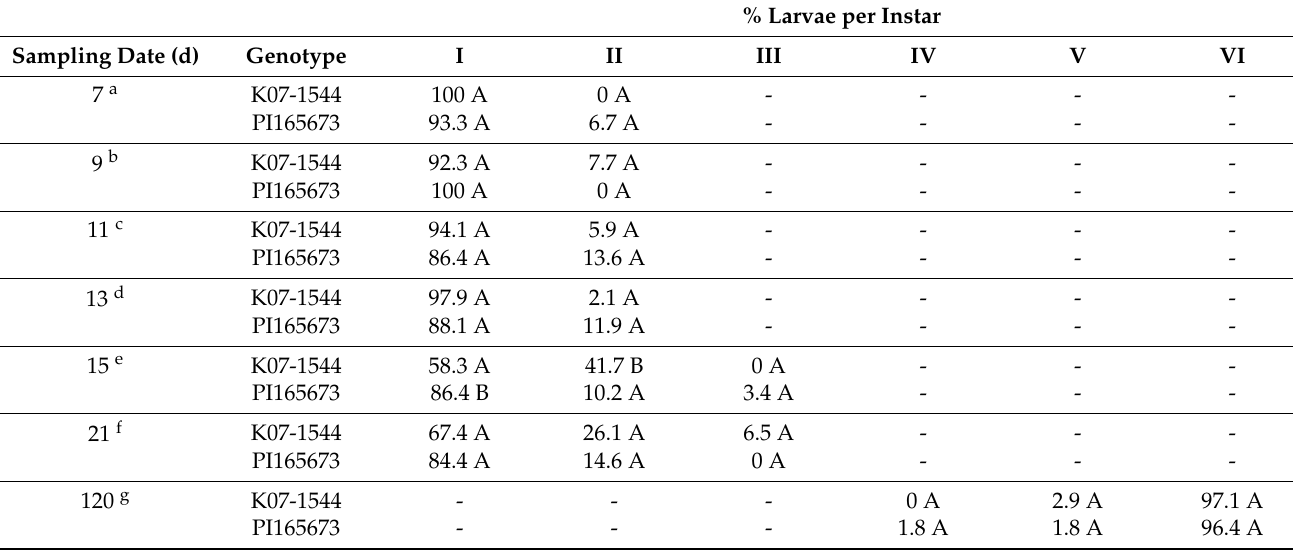
Table 6. Percentage of larvae per instar in soybean genotypes K07-1544 and PI165673 infested with Dectes texanus in 2014. % Larvae per Instar